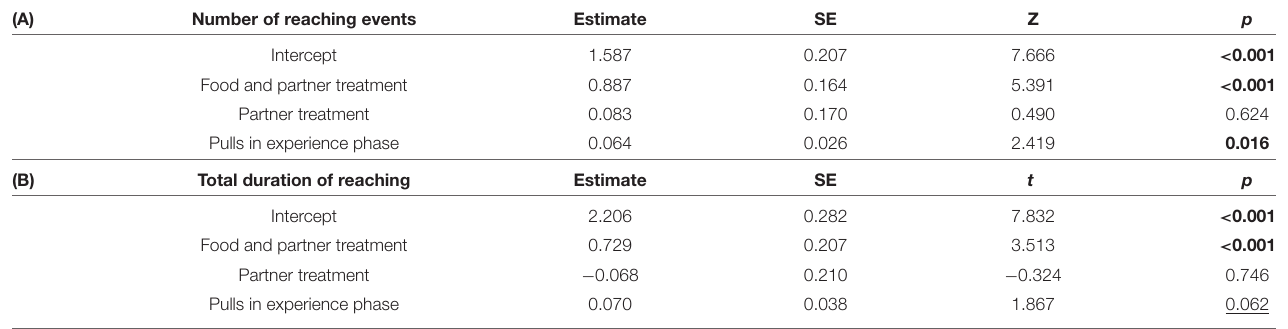
TABLE 1 | Effects of experimental treatment and previous helpful acts on (A) the number and (B) duration of reaching events, using GLMMs with a negative binomial or gamma distribution (log-link), respectively.